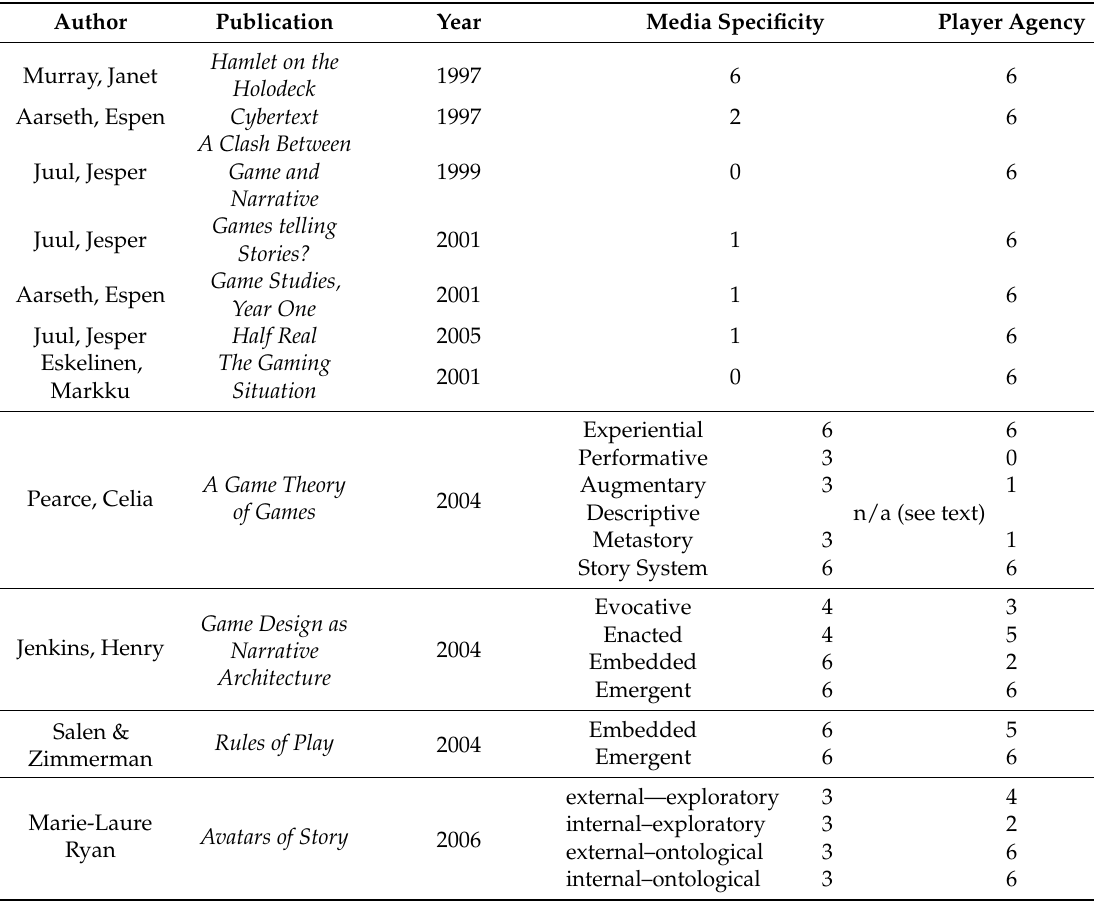
Table 3. Positions in the analyzed